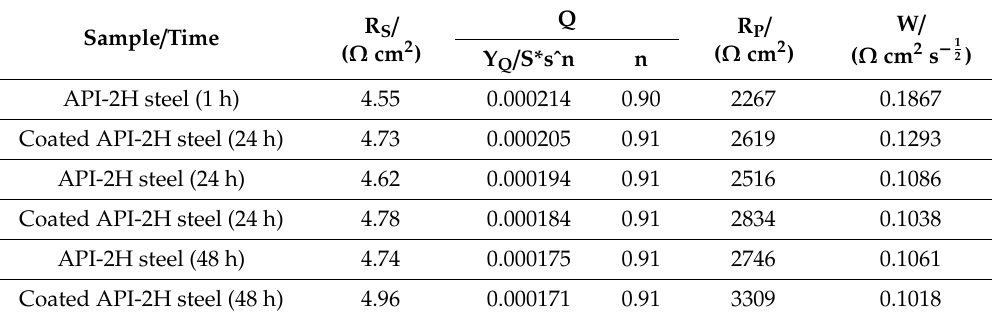
Table 2. Impedance (EIS) parameters of the uncoated and coated API steels in NaCl solutions. Sample / Time